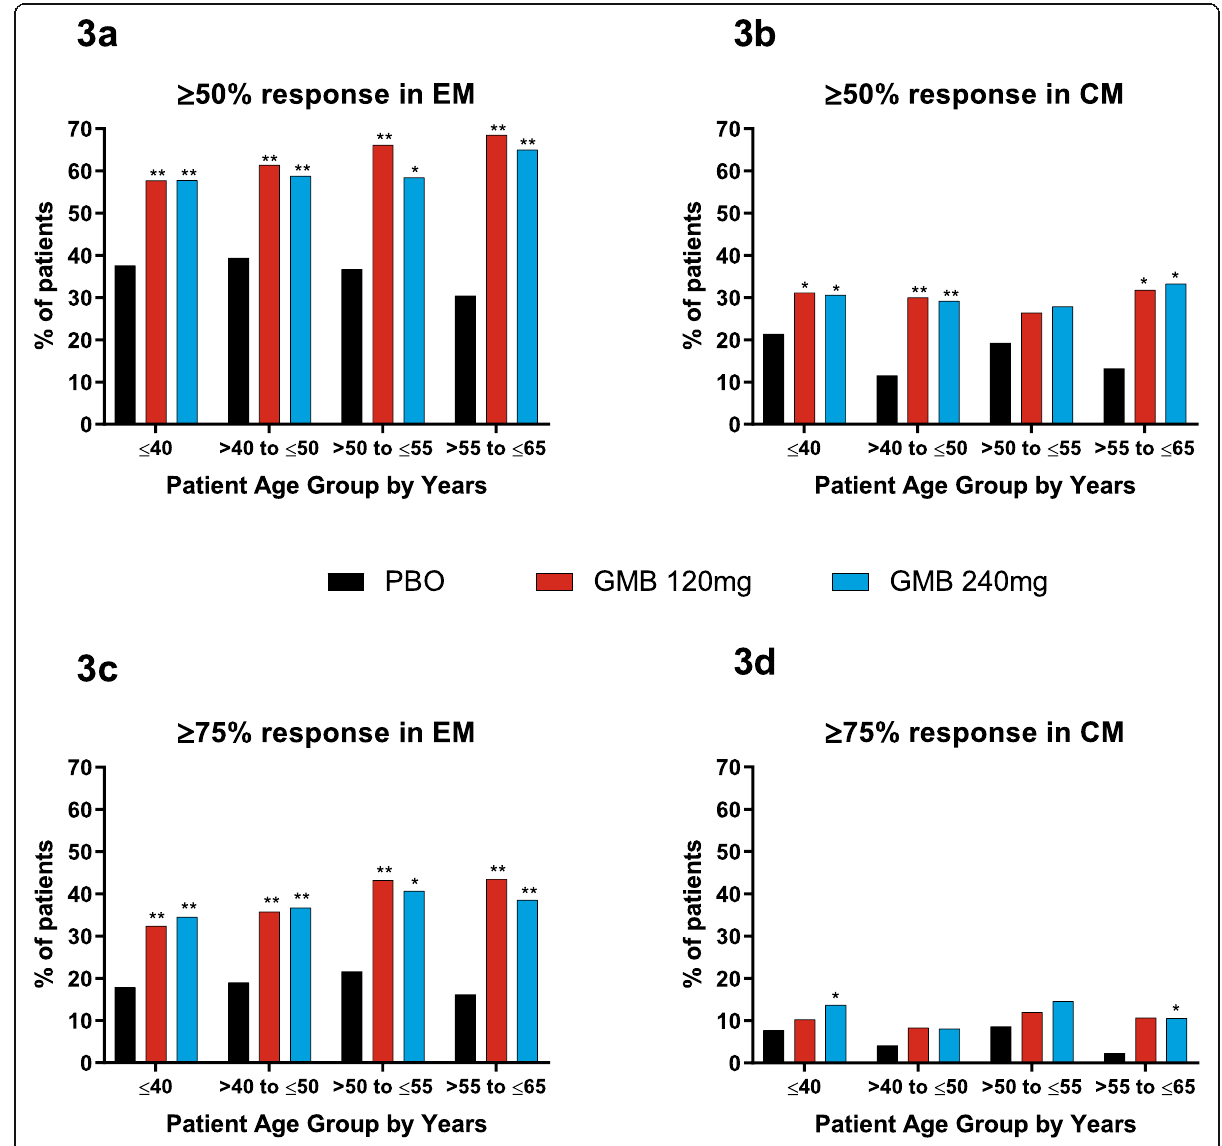
Fig. 3 Percentages of patients with ≥ 50% and ≥ 75% reductions in migraine headache days, by age